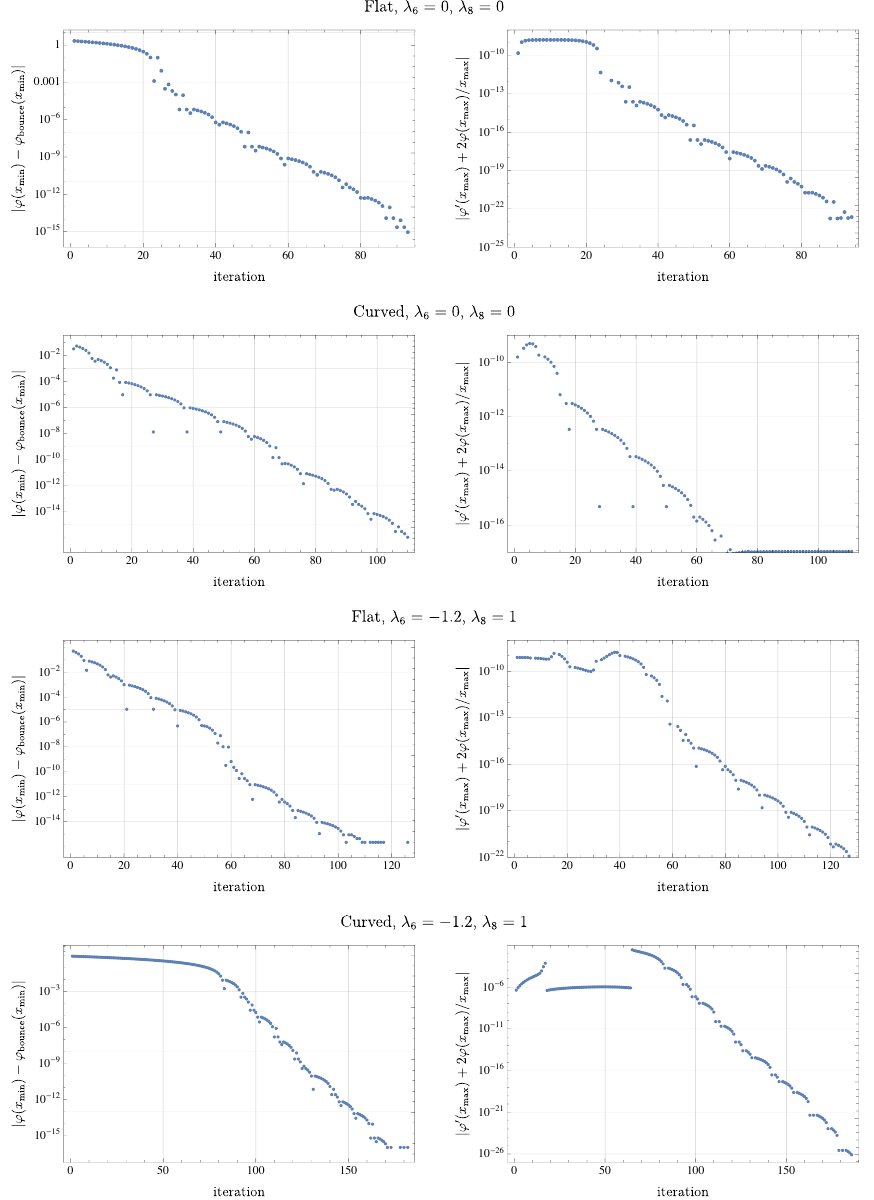
Figure 6 . Convergence of ’ ( x min ) to its (cid:12)nal value (left column), as well as of ’ 0 ( x max ) + 2 ’ ( x max ) =x max to zero (right column), in the four cases ((cid:13)at and curved, with and without new physics) discussed in the